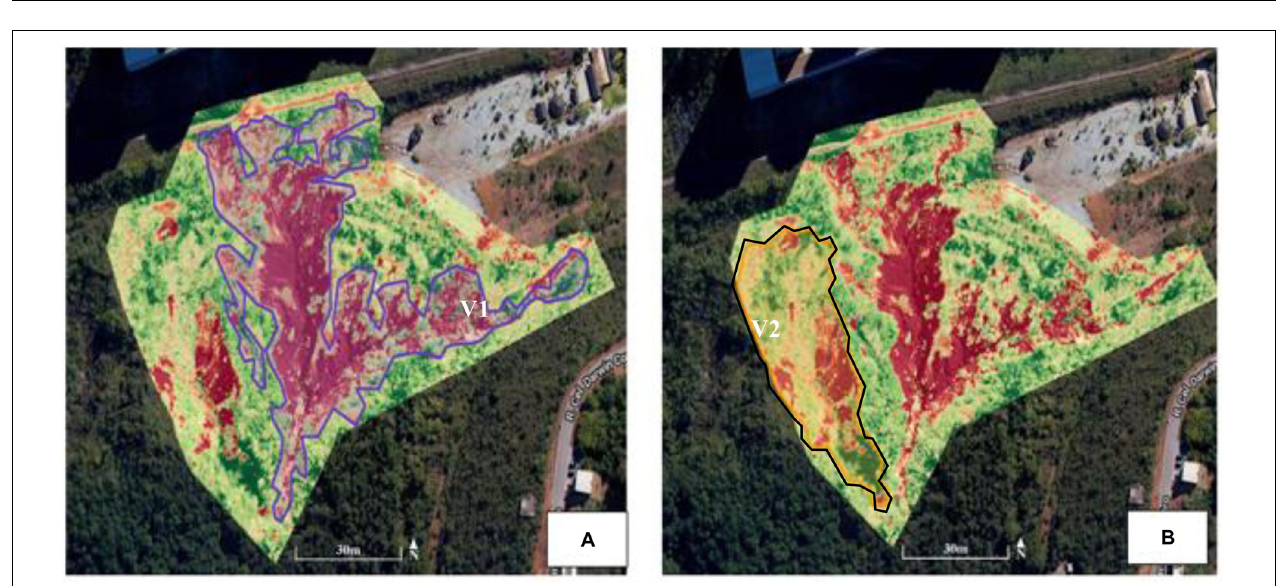
FIGURE 12 | Gullies surface and digital elevation models in the study area, Nova Lima-MG, Brazil. (A) Surface digital model; (B) elevation digital model. Positive values represent points above the reference and negative values represent points below the reference (in meters). Reference (drone takeoff point = 0 m).